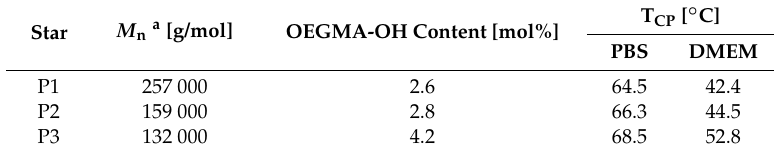
Figure 4. Transmittance as a function of temperature for P(DMAEMA- co -OEGMA-OH) stars in PBS buffer and Dulbecco’s modified Eagle’s medium (DMEM) ( λ = 700 nm, c = 1 g/L). Table 4. Phase transition temperature data of the P(DMAEMA- co -OEGMA-OH) star copolymers.